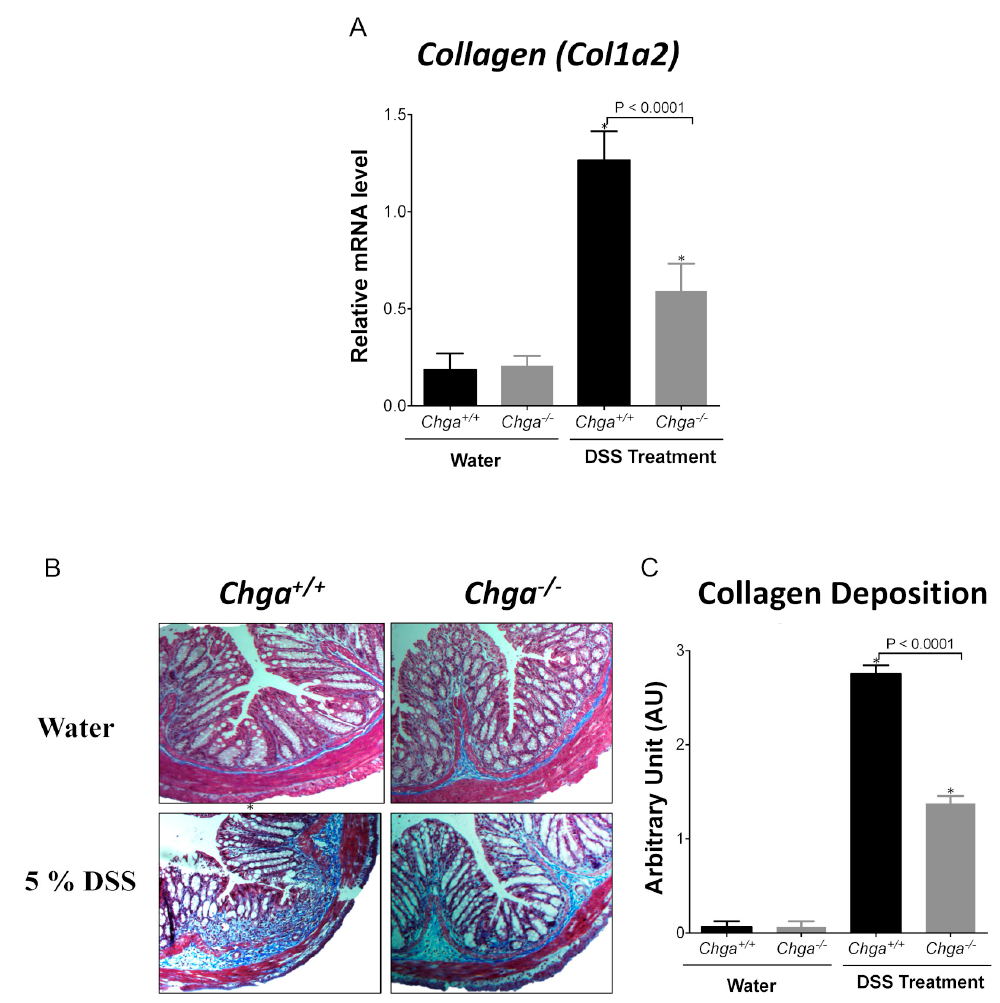
Figure 2. Deletion of chromogranin-A gene ( Chga ) attenuates collagen deposition and expression in acute dextran sulphate sodium (DSS)-induced colitis. Wild-type ( Chga +/+ ) and Chga -knockout ( Chga − / − ) mice were given 5% DSS solution for five days in the drinking water to induce colitis. Control mice received water without DSS. Mice were sacrificed at day five, and colonic tissues were processed for further analysis. ( A ) RT-qPCR of Col1a2 mRNA expression in colonic tissues. ( B ) Masson Trichrome staining (collagen stained in blue) at magnification of 100x, and ( C ) collagen deposition scores. One-way ANOVA followed by Tukey’s multiple comparison test. Each value represents the mean ± SEM, n = 6–8 per group. * p < 0.005 refers to significance compared with water treatment groups.